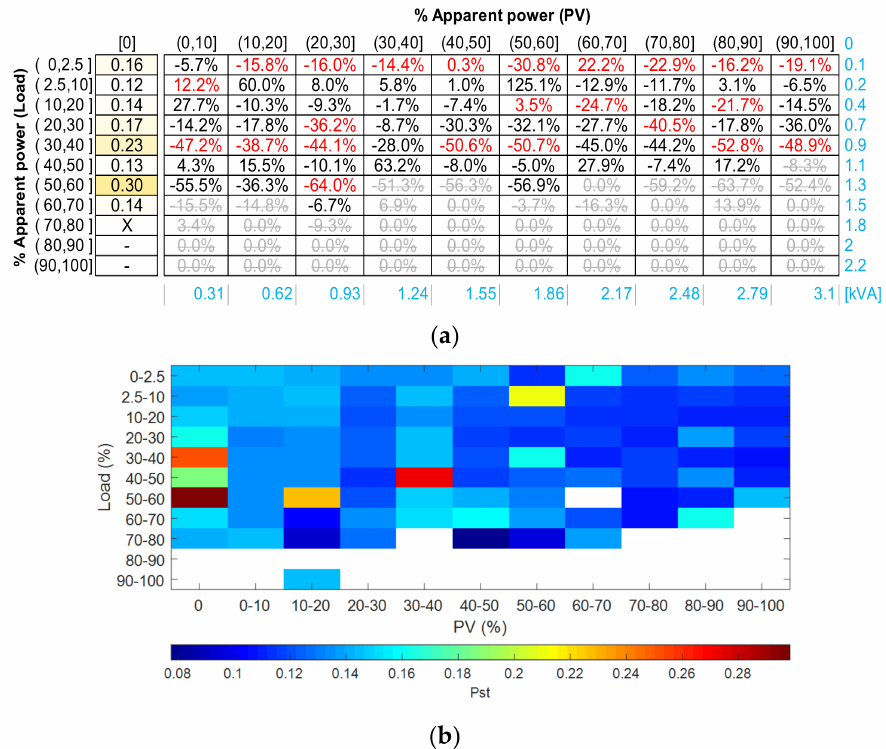
Figure 24. Behaviour of Pst : ( a ) matrix of Pst values for PVS Of f scenarios and variations of Pst values for PVS On scenarios of Phase A, and ( b ) average value per scenario.